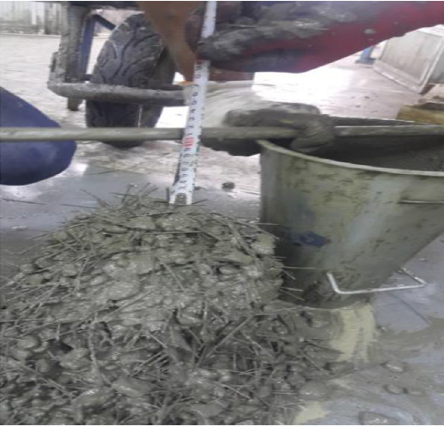
Figure 2: Polyole fi n fi ber in concrete mix – SikaFiber ® Force - 6.